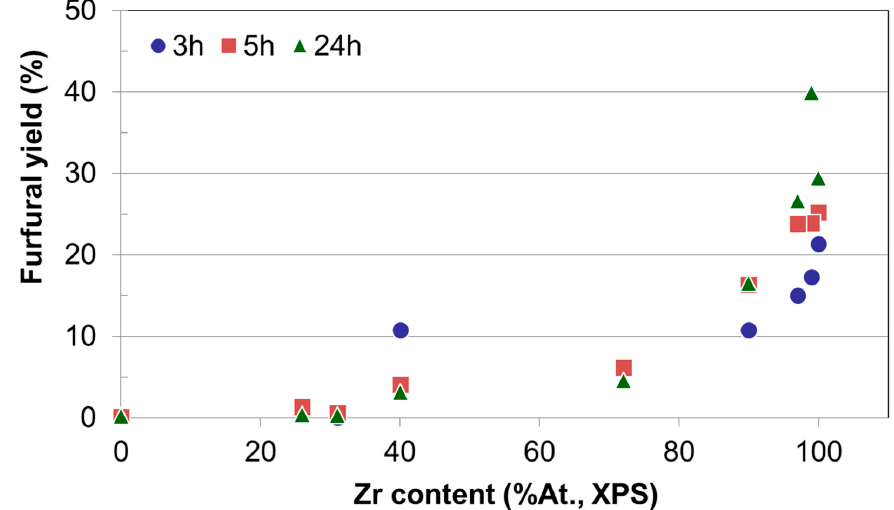
Figure 10. Furfural yield in xylose dehydration as a function of zirconium content (XPS) obtained after 3, 5 and 24 h of reaction at 150 °C in toluene/water reaction medium.